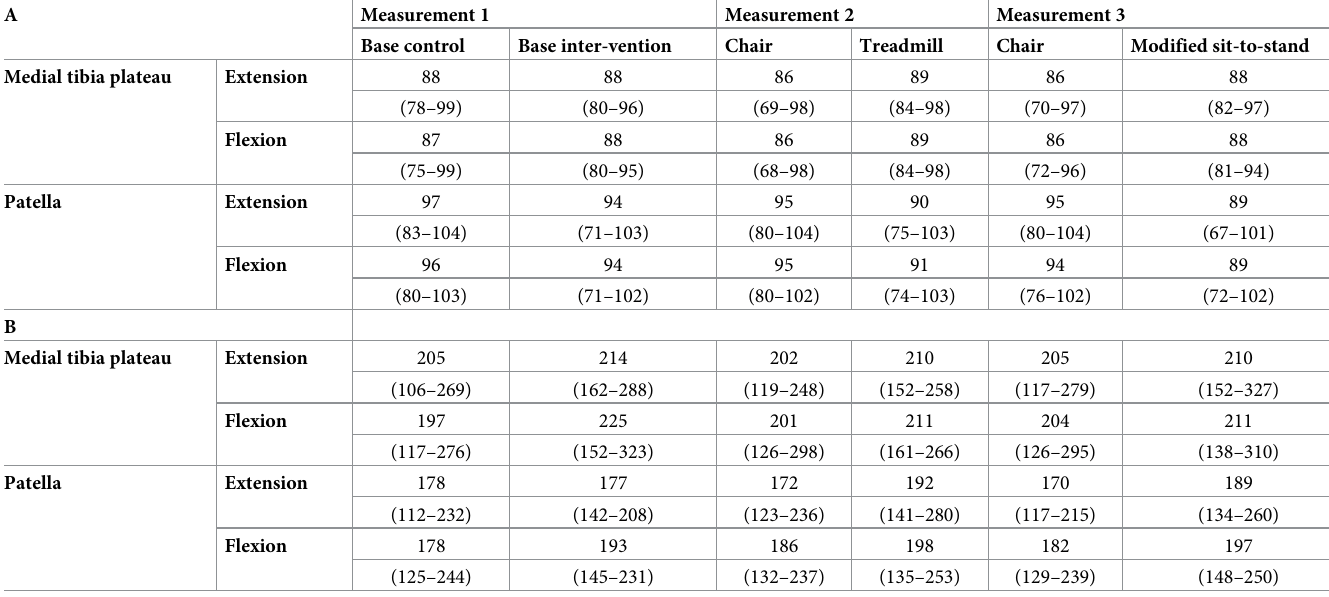
Table 2. Mean (range) of the mean sound amplitude (A) and of the median power frequency (B) from the five repetitions of extension and flexion during the differ- ent measurement times in the control and intervention